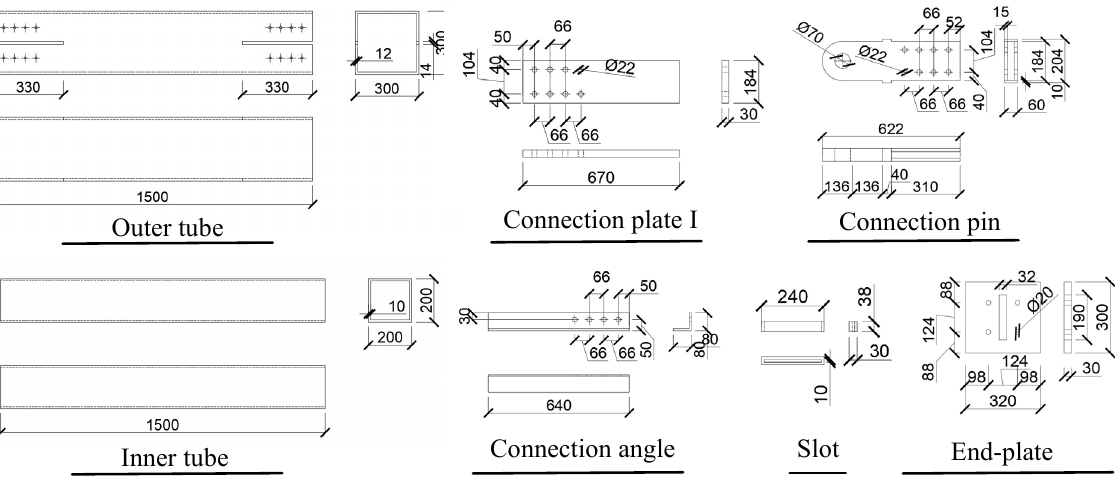
Figure 9. Dimensions of the SCVEB (units in mm).